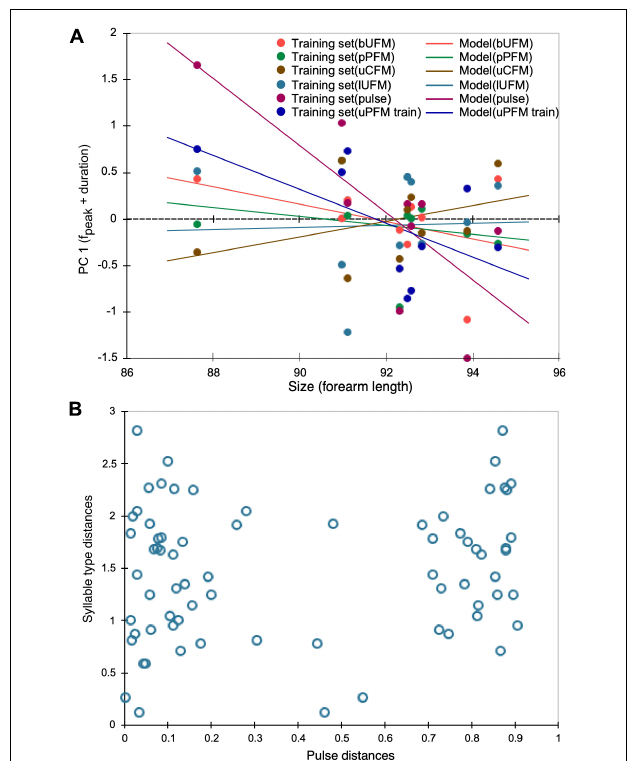
FIGURE 3 | (A) Scatterplot of data points and regression line plots for model fit with body size (forearm length), incorporating all acoustic parameters measured for each syllable type at different geographic locations. (B) Scatterplot for Mantel test of correspondence between the matrix of acoustic distances for echolocation pulses and that of multiparametric acoustic distances for all syllable types. No significant correspondence was observed between the two acoustic distance